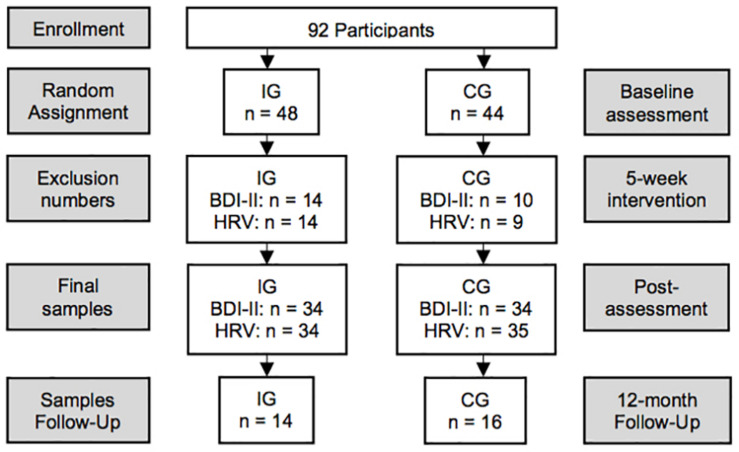
Study design. N = 92 in-patients enrolled in the study and were randomly assigned to the intervention (IG) or control group (CG). Due to dropouts, missing items in the BDI-II, side effects from medication, illness, artifacts in the ECG, and missing assessments, the final sample size was reduced to 68 for the depression pre–post and to 69 for the HRV pre–post analyses, respectively. Overall, 30 participants (IG = 14; CG = 16) returned the follow-up questionnaires.